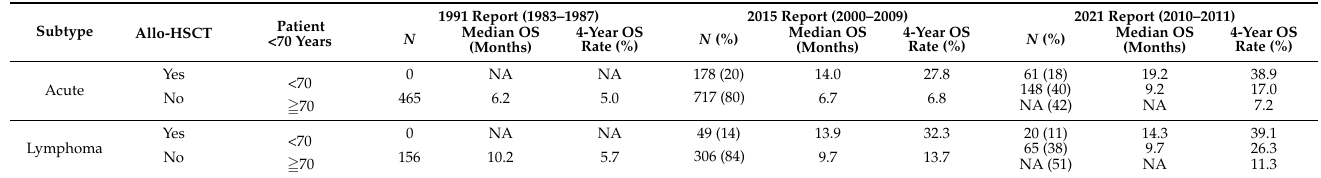
Table 5. Survival of the patients treated with or without allogeneic hematopoietic cell transplantation (Allo-HSCT).